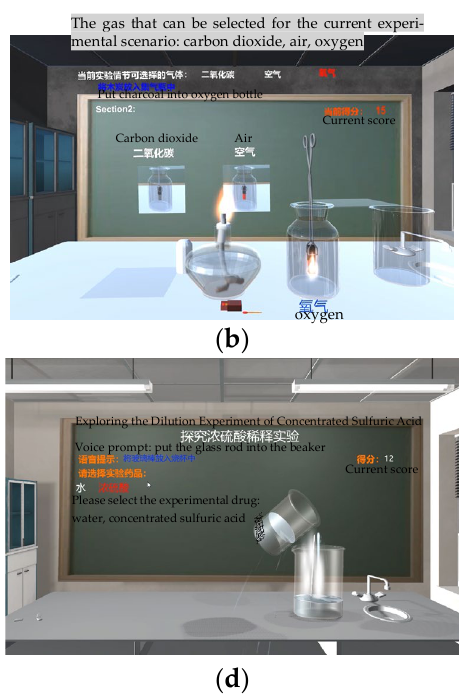
Figure 14. Prototype system interface.